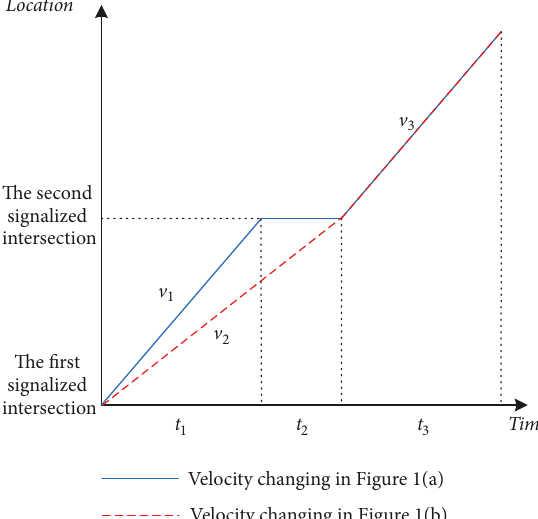
Figure 3: The velocity changing of two cases in Figure 1.